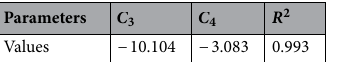
Table 1. The fitted parameters of shift factor.